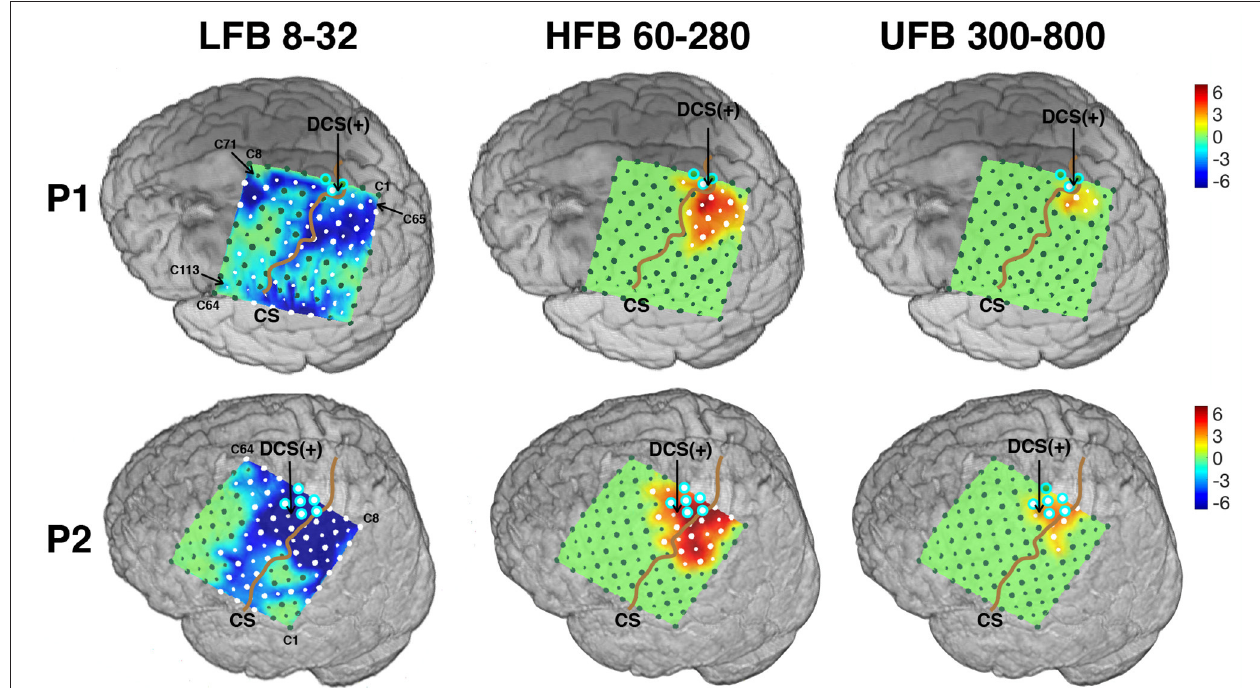
FIGURE 7 | Spatial spectral activities mapped onto subject’s individual 3D MRI texture rendering. All maps were thresholded to reveal only channels with significant power changes of 25% or more (one tailed t -test, p < 0.05, fdr < 0.05). DCS ( + ) site for hand function was pointed out by an arrow for each subject. Contacts located on the “hand knob” were outlined in cyan. The central sulcus (CS) was accentuated by a brown curve. Significantly activated channels were marked as white. Peak activated channels (P) were also pointed out. The naming conventions of both large and small contacts are shown in the first map. All maps were displayed from − 6 to 6